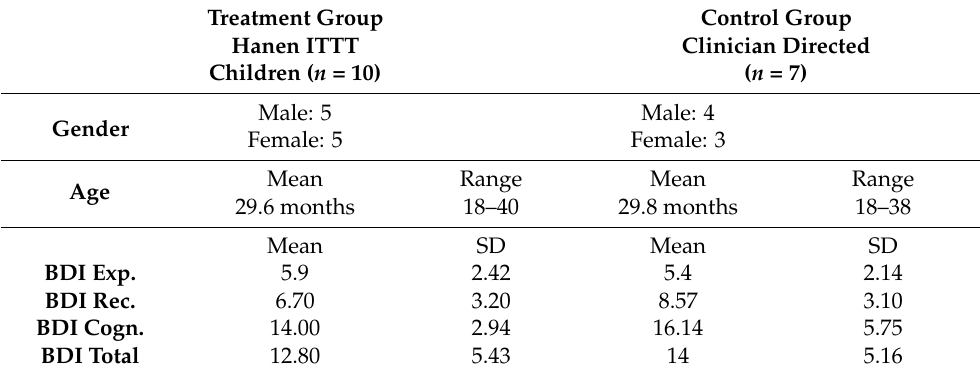
Table 2. Children’s characteristics in terms of communication, cognition, and global development. Treatment